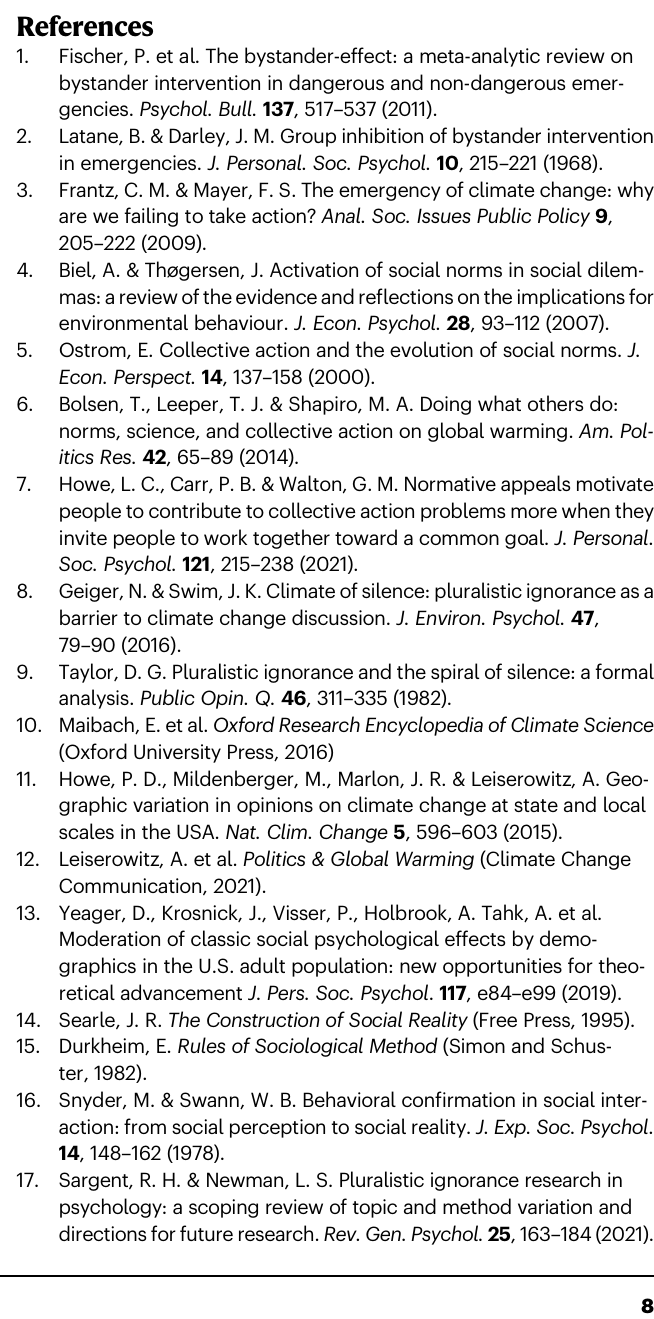
Siting renewable Energy on public lands Green new